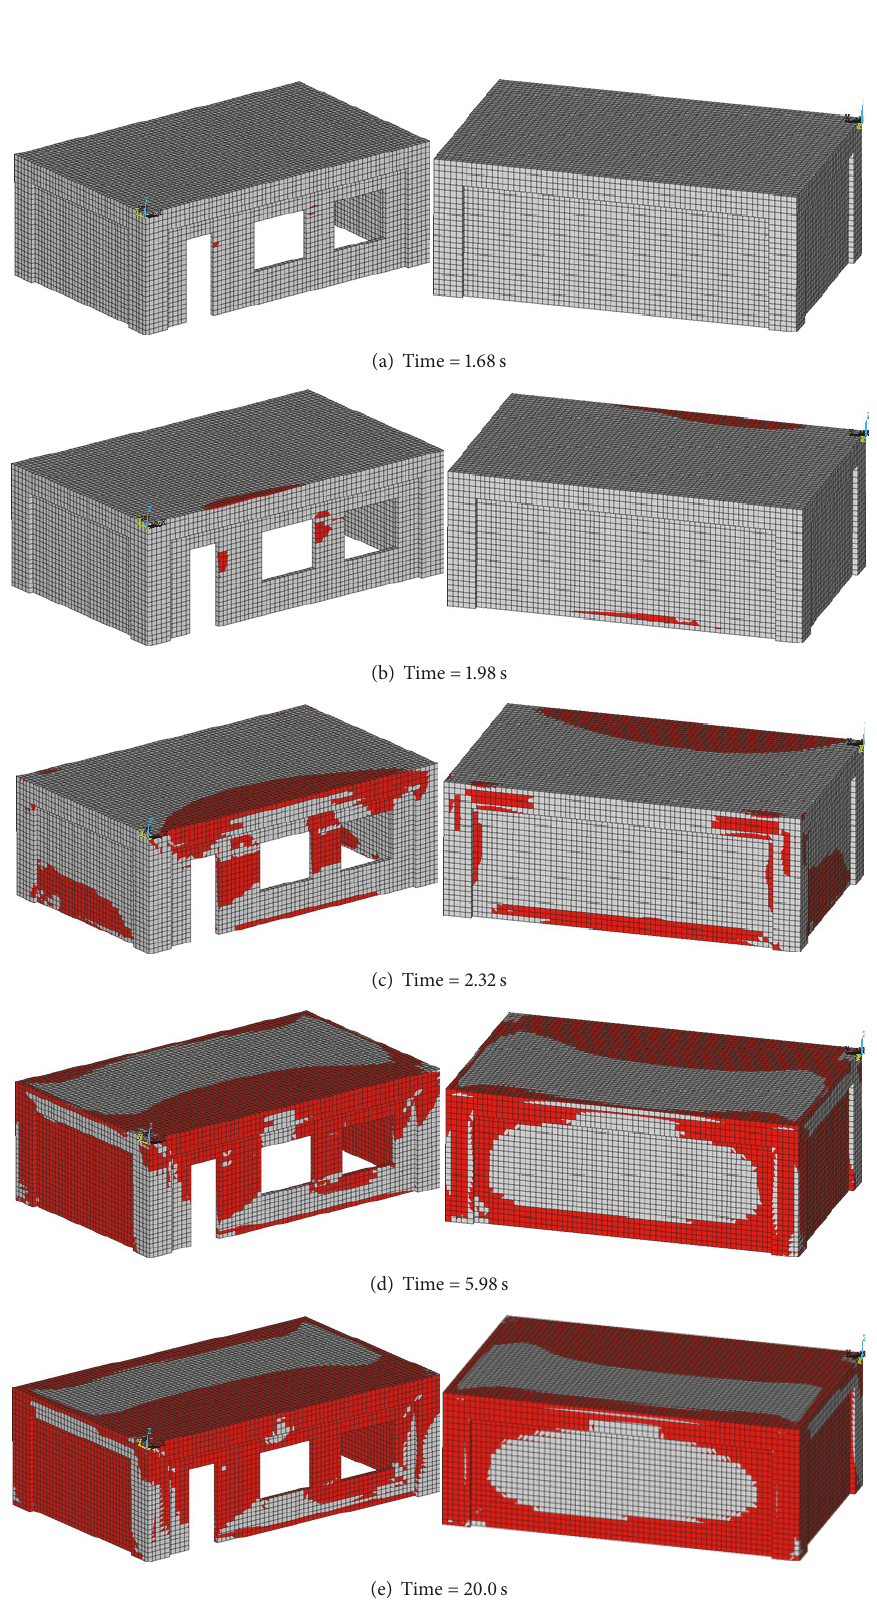
Figure 9: Damage distributions of the original masonry structure at different